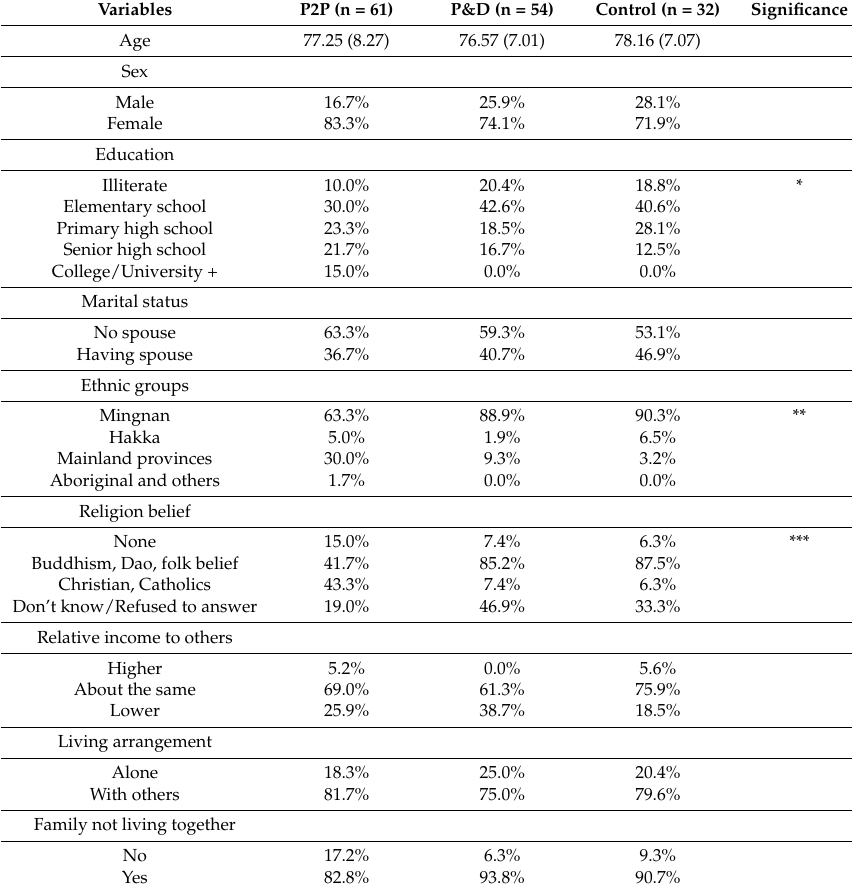
Table 1. Demographics of the participants at baseline (mean (SD) or %).